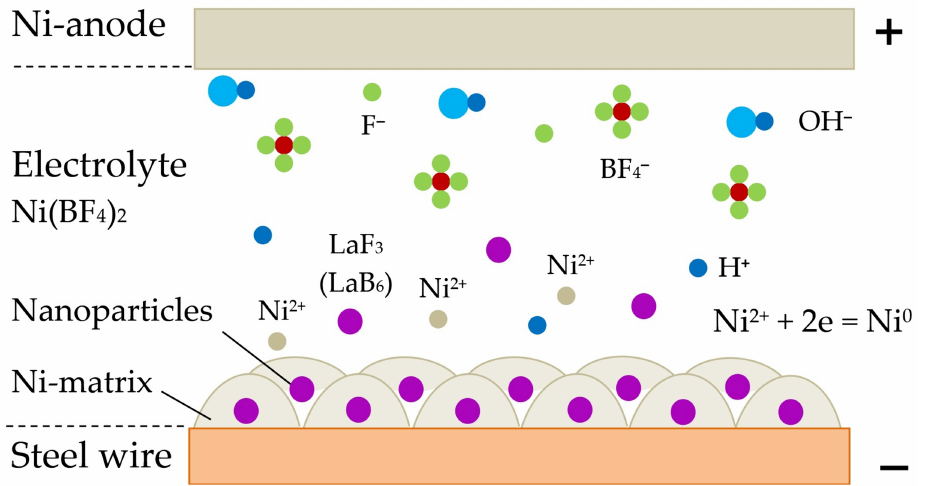
Figure 4. The mechanism of electrochemical ion adsorption and formation of the composite coating in the colloidal solution of Ni(BF 4 ) 2 in ethanol C 2 H 6 O containing nano-dispersed insoluble LaF 3 or LaB 6